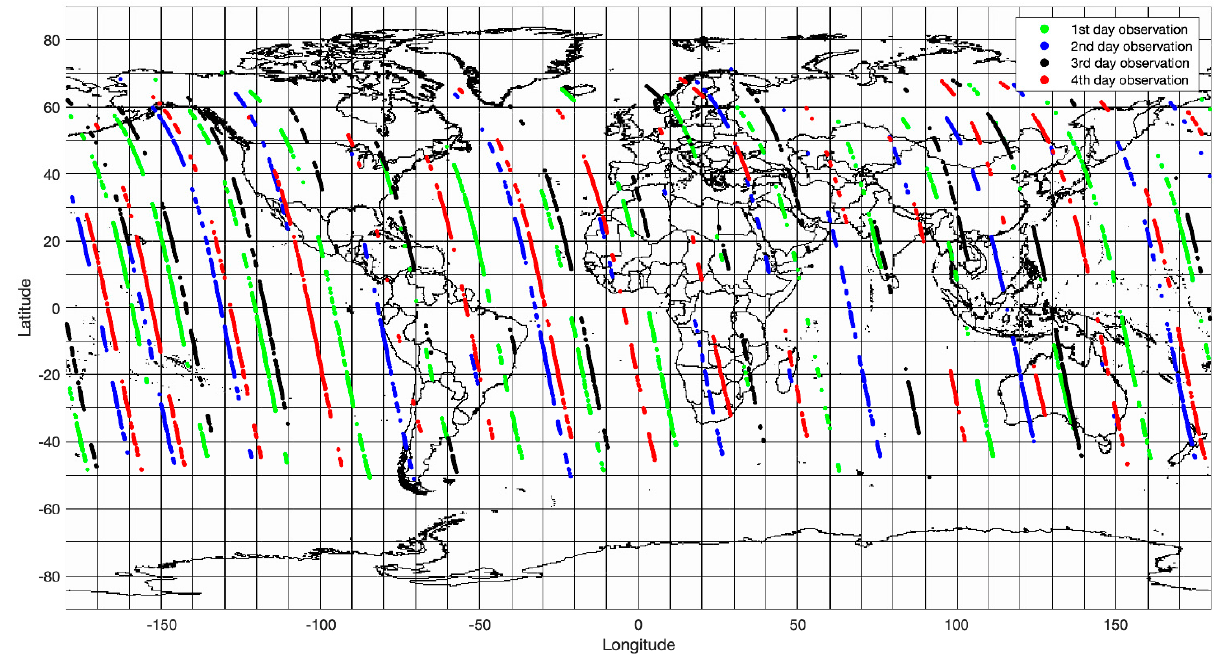
Figure A3. OCO2 4-day observation, 22.04.2019–25.04.2019.